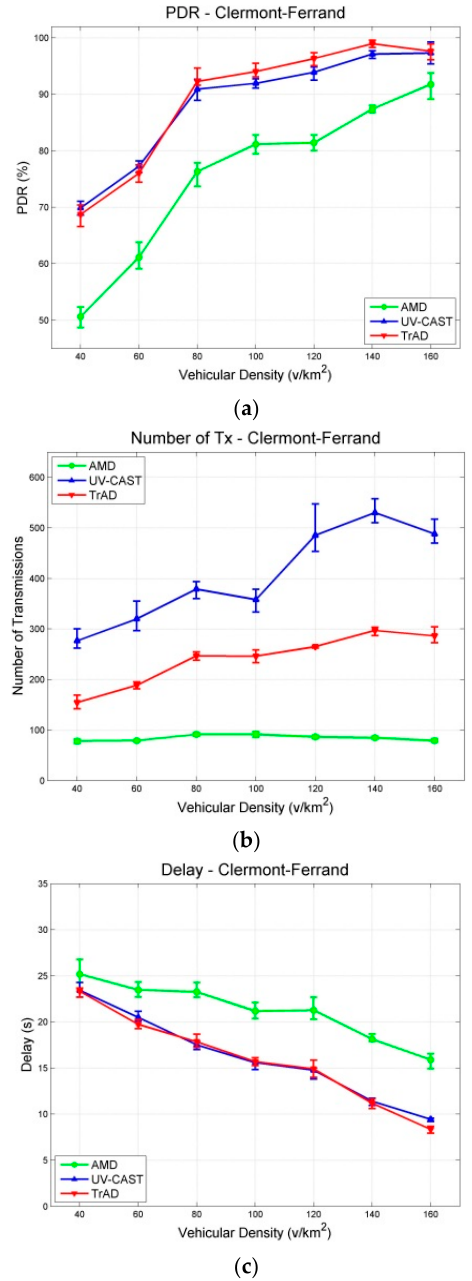
Figure 7. Results with a 95% confidence interval in Clermont-Ferrand scenarios: ( a ) PDR; ( b ) Number of Transmissions; ( c ) Delay.